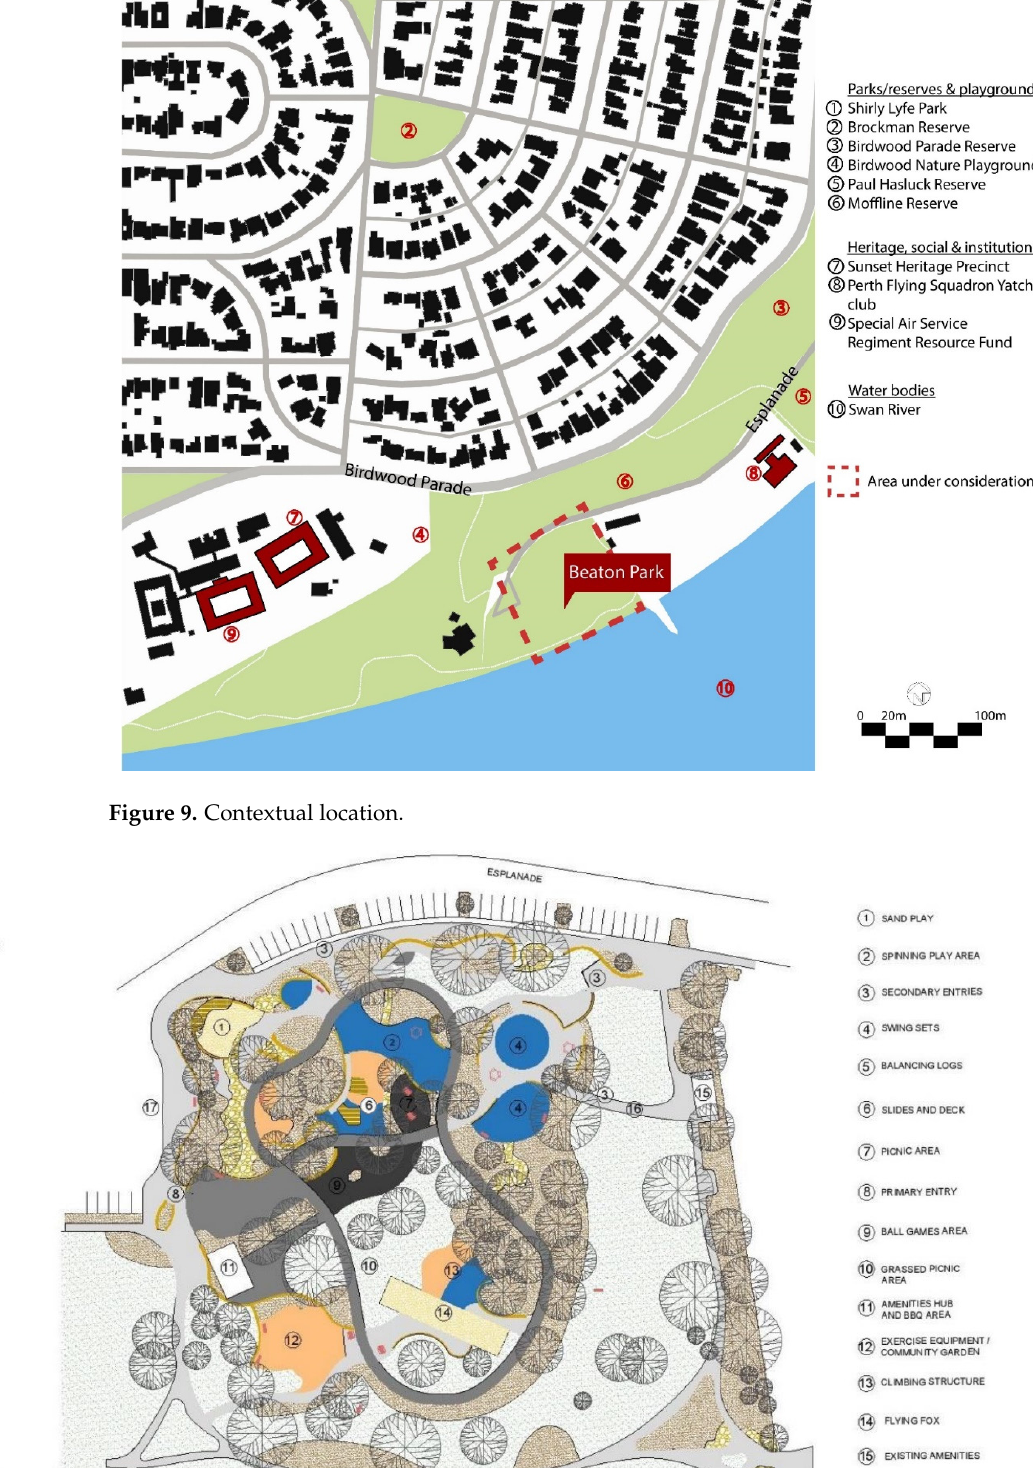
Figure 10. Site Figure 10. Site Plan. Table 3. Materials, their respective albedo values, and UPF offered [31].